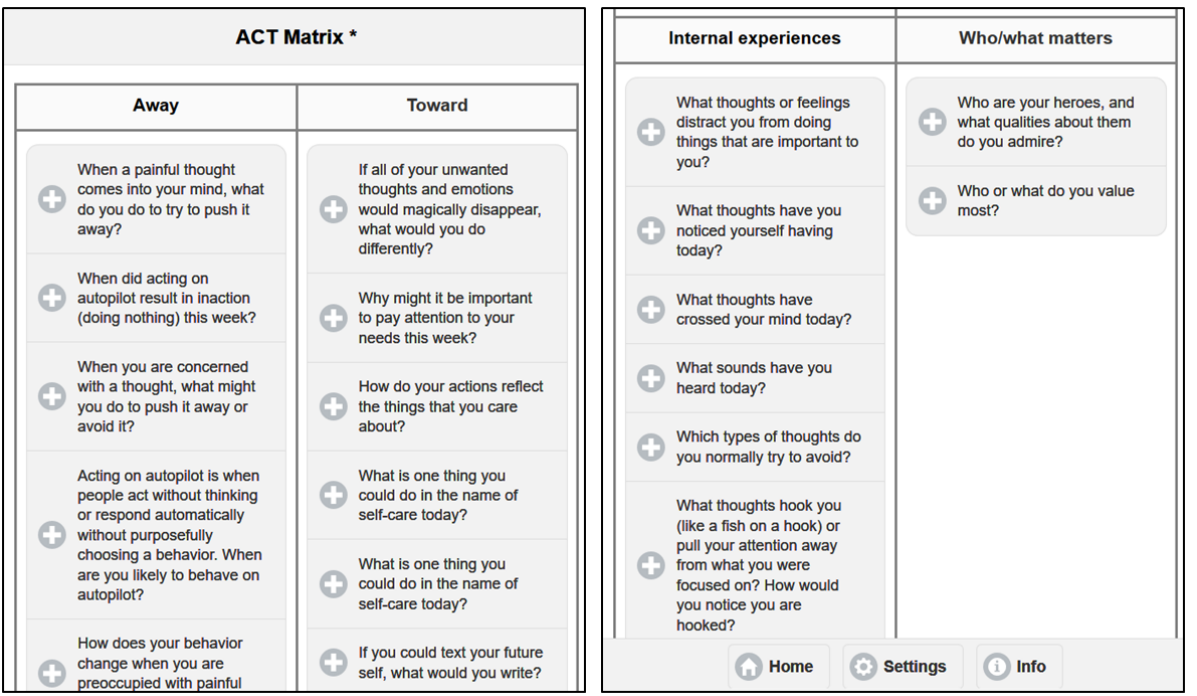
Figure 3. Review function of the Lorevimo app. The first image (left) represents the top half of the acceptance and commitment therapy (ACT) matrix, which sorts the function of behaviors. The second image (right) represents the bottom half of the ACT matrix, which sorts internal experiences and values (ie, who or what matters).